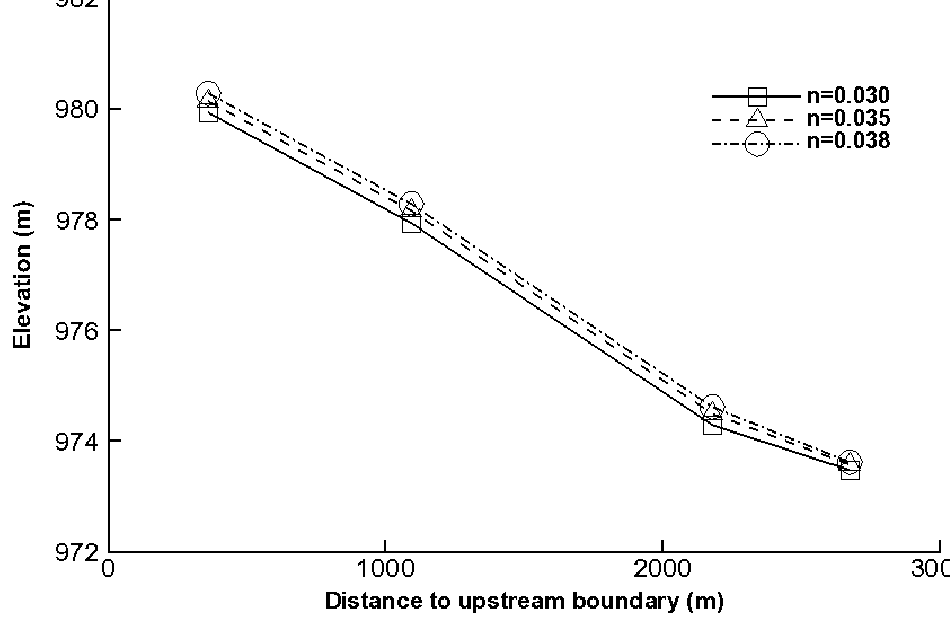
Figure 5. Comparison of the water levels for different values of the Manning coefficient, n .